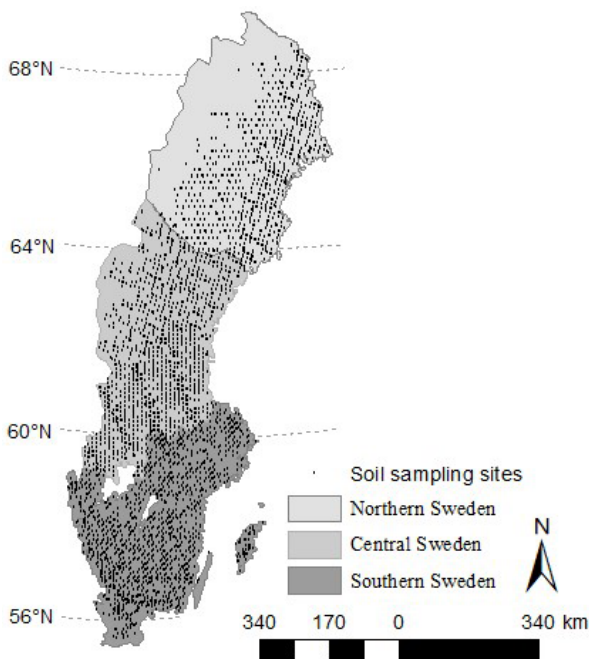
Figure 1. Sites from the Swedish Forest Soil Inventory for northern, central, and southern